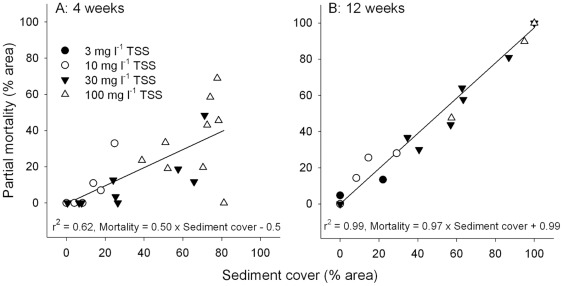
Regressions of sediment cover (%) against partial mortality (%) of the surface tissues M. aequituberculata at (A) 4 and (B) 12 weeks (n  = 9).